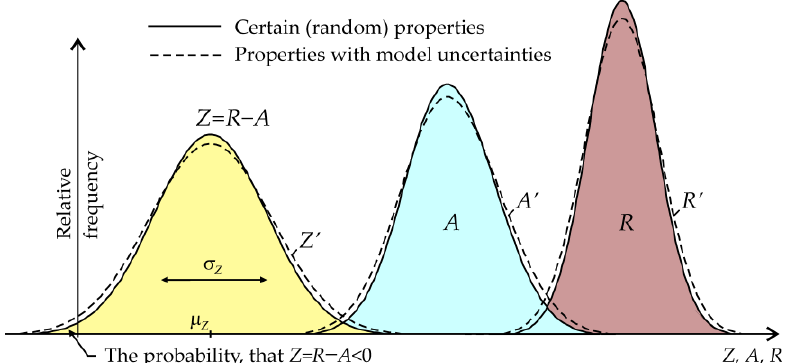
Figure 2. Model uncertainties in the limit state concept.